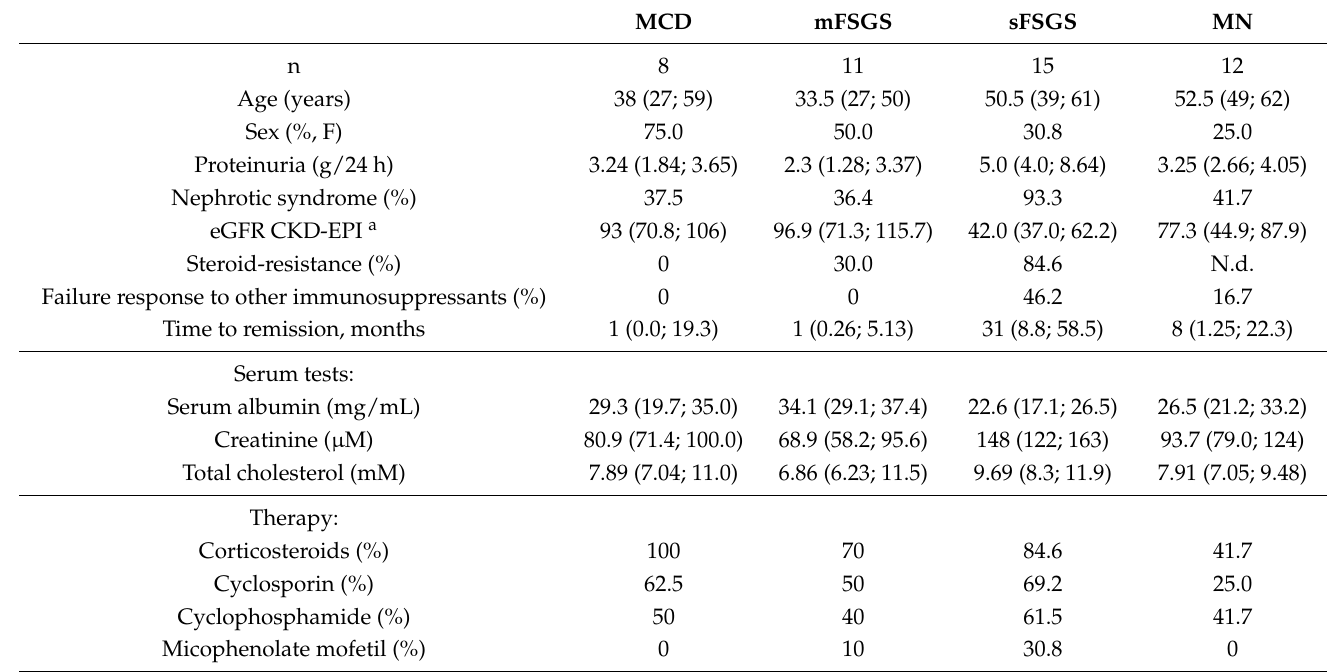
Table 3. Characteristics of the 46 CKD patients.